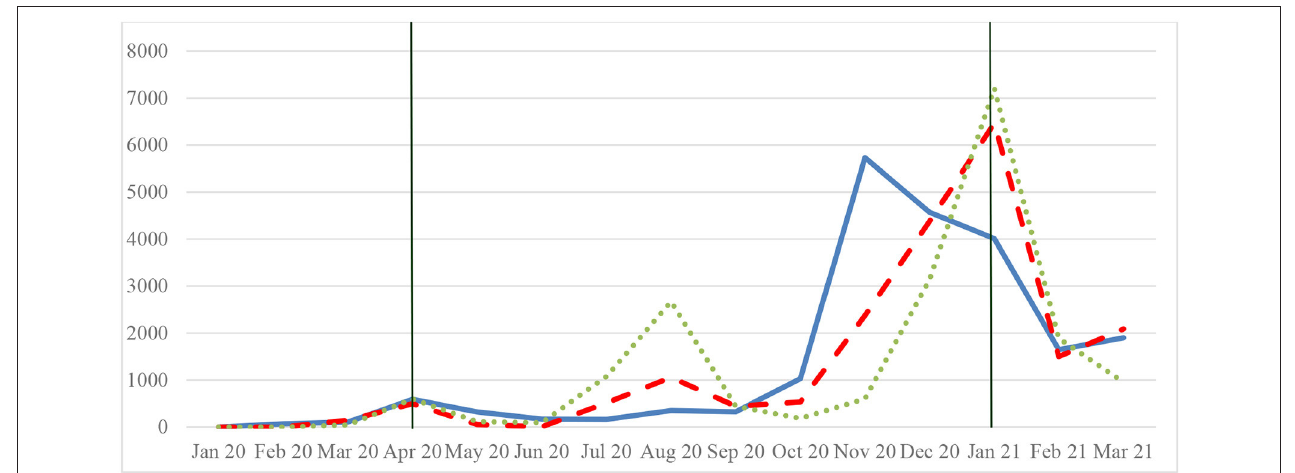
FIGURE 2 | Trends in confirmed COVID-19 cases among the three prefectures. Hokkaido (blue bold line), Hyogo, and Fukuoka (dotted line), January 2020–March 2021. The daily numbers of confirmed COVID-19 cases are taken from the NHK (Nippon Hoso Kyokai); monthly data were created by the author. The green vertical line shows the declaration of the state of